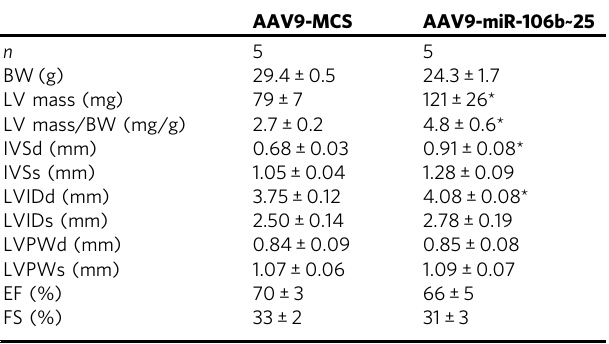
Data are expressed as means±SEM. BW body weight, LV left ventricular, IVSd interventricular septal thickness at end-diastole, IVSs interventricular septal thickness at end-systole, LVIDd left ventricular internal dimension at end- diastole, LVIDs left ventricularinternal dimensionat end-systole, LVPwd left ventricularposterior wall thickness at end-diastole, LVPws left ventricular posterior wall thickness at end-systole, EF ejection fraction, FS fractional shortening, E/A Doppler E/A ratio. *Indicates P <0.05 vs sham group subjected to treatment with a control antagomir. # Indicates P <0.05 vs experimental